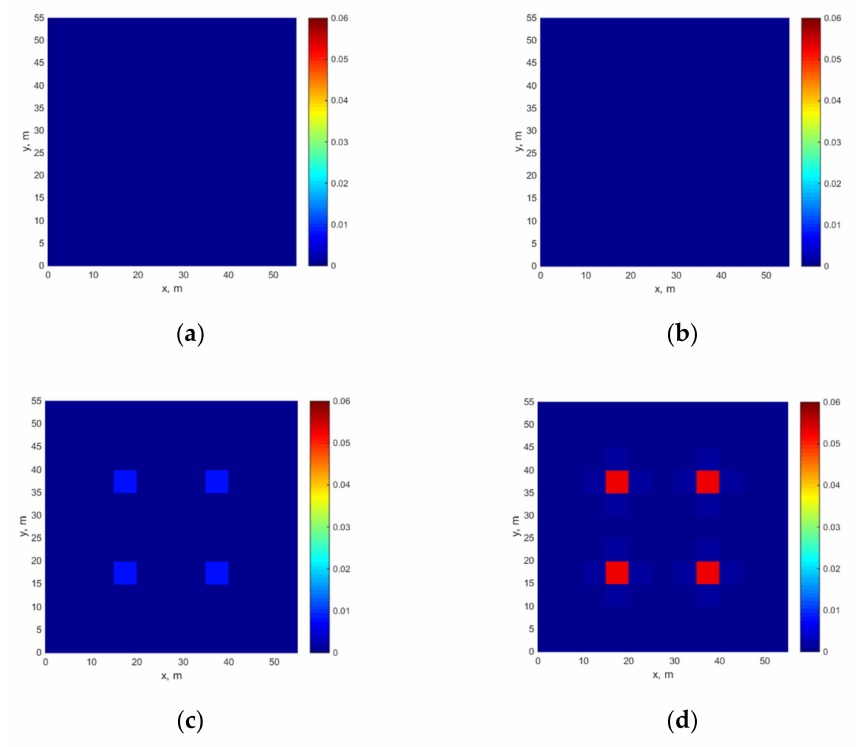
Figure 7. Reservoir oil saturation profiles calculated by this method. ( a ) The 0.001th day; ( b ) the 10th day; ( c ) the 30th day; ( d ) the 200th day.